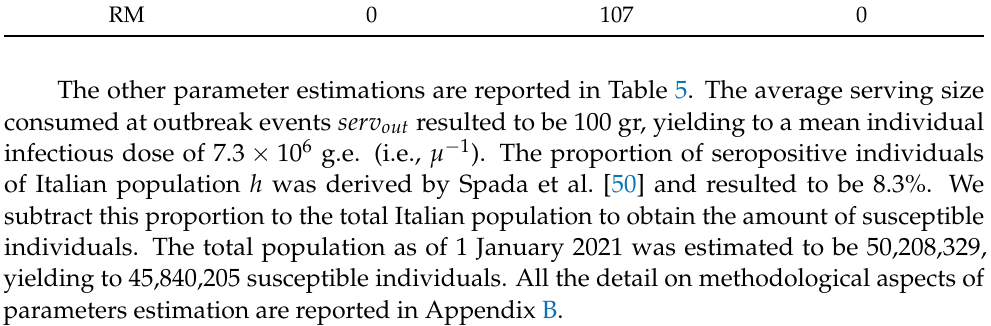
Table 4. Mean viral load per serving (g.e./gr) E ( C i